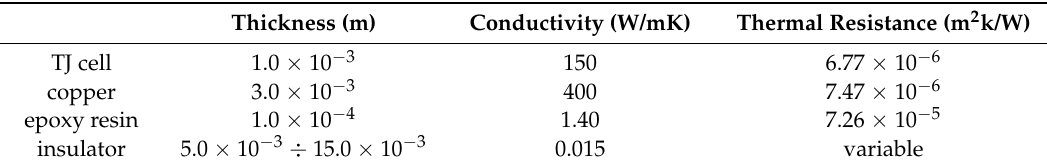
Table 2. Thermal properties